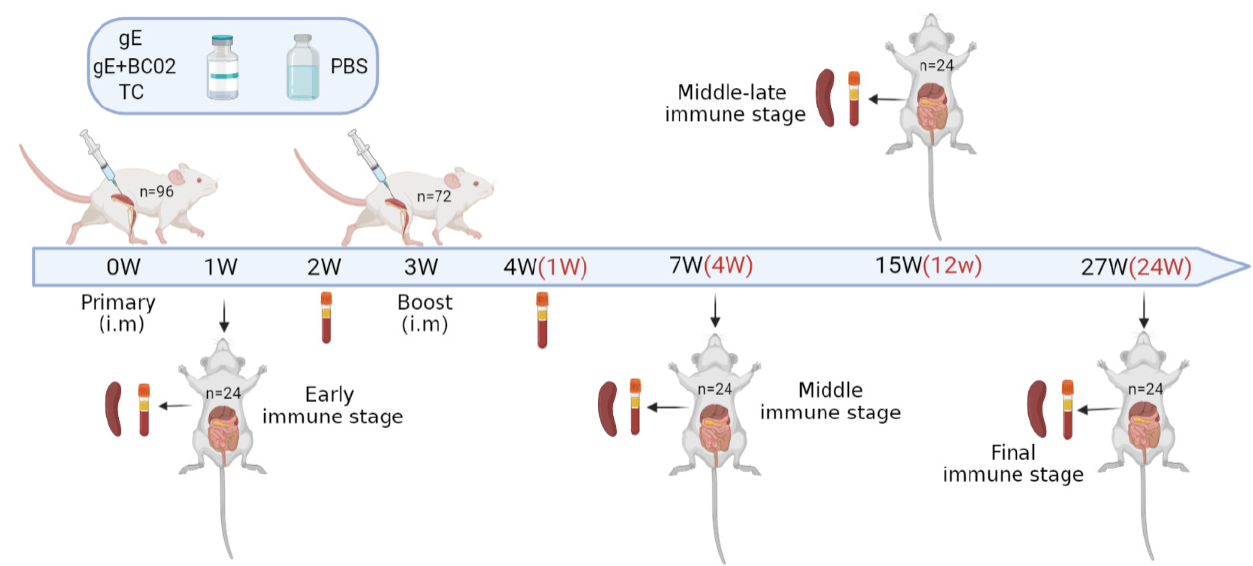
Figure 1. Mouse immunization and sampling schedule. Ninety-six mice were randomly divided into four groups and booster immunizations were performed at intervals of 3 weeks after the primary immunization. Peripheral blood was collected at six different time points, of which four different time points were sacri- ficed and the spleens were taken and spleen lymphocytes were isolated for immunological detection. TC is the abbreviation of test control.